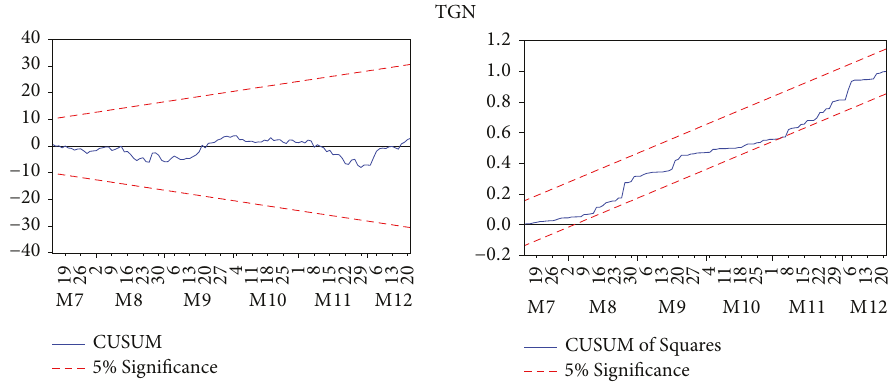
Figure 9: CUSUM test and CUSUM of square test of each ARDL model. Source: author’s own work. Notes: for the definition of variables, please see Table 2.